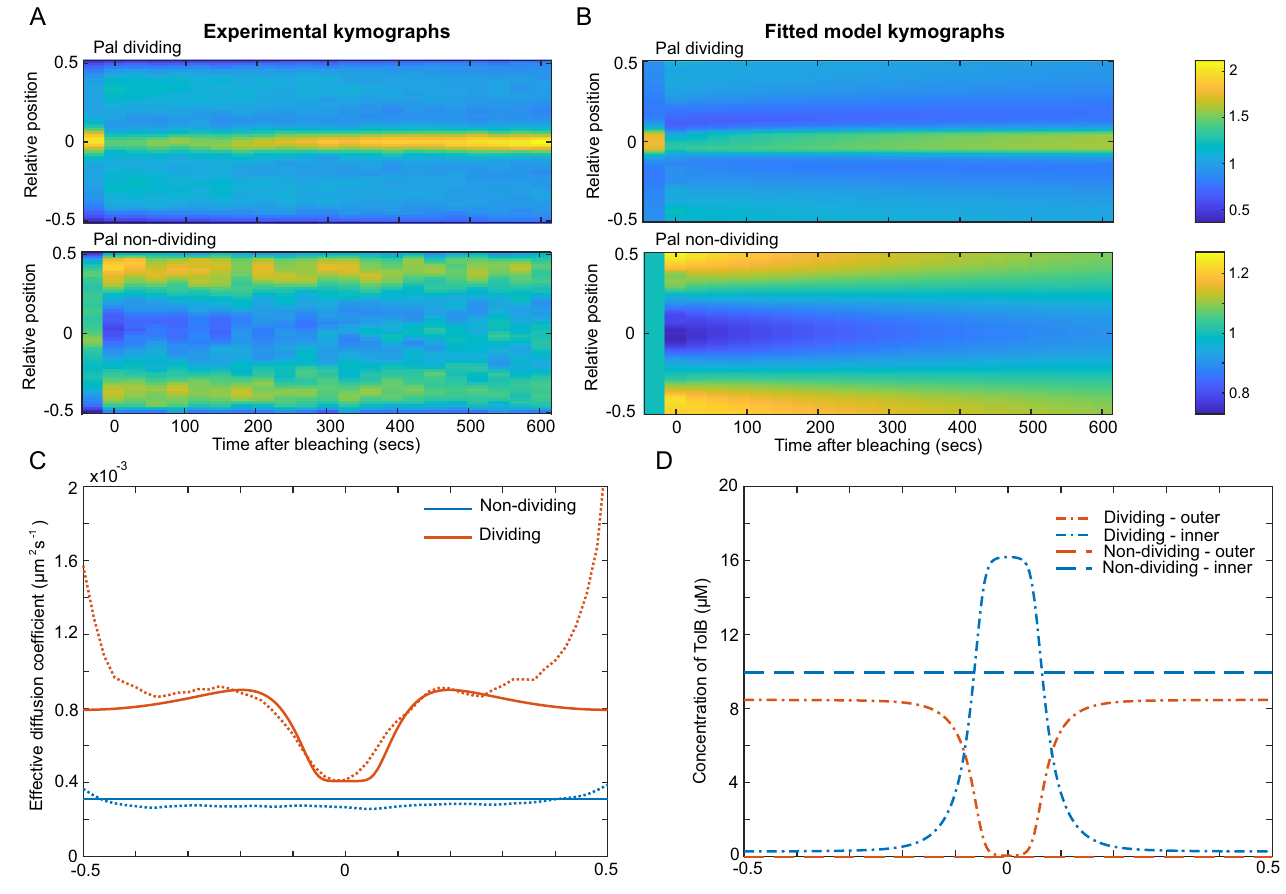
Fig 4. Fitting the model to experimental Pal SpatialFRAP. (A) Kymographs of FRAP of Pal-mCherry performed averaged over 30 dividing (top) and non- dividing (bottom) cells. See also S3 Fig. (B) Simulated kymographs from the mathematical model showing the results for the best fit to the experimental data in (A). Colour bars are for both (A) and (B) and show either the normalised fluorescence (experimental data) or the normalised concentration (simulations). (C) Comparison between the effective diffusion coefficient computed using the SpatialFRAP method from the average experimental kymographs in (A) (dashed lines) and the best fit of the model (solid lines) for Pal in non-dividing (blue lines) and dividing (orange lines) cells. (D) The distribution of TolB in the inner (blue lines) and outer periplasm (orange lines) for dividing (dot-dash lines) and non-dividing (dashed lines) cells for the best fit shown in (B). Note the greater concentration of TolB in the outer periplasm of dividing cells (compare orange